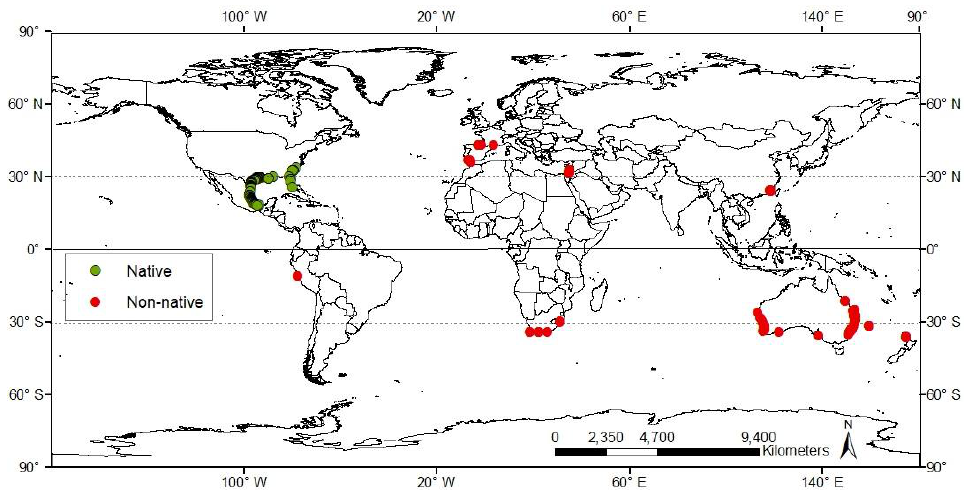
Figure 1. Geographic distribution of O. drummondii subsp. drummondii . Green dots show occurrence records of native distribution, blue dots show records of non-native distribution. The solid black line represents the Line of the Ecuator and the dashed lines represent the intertropical region.